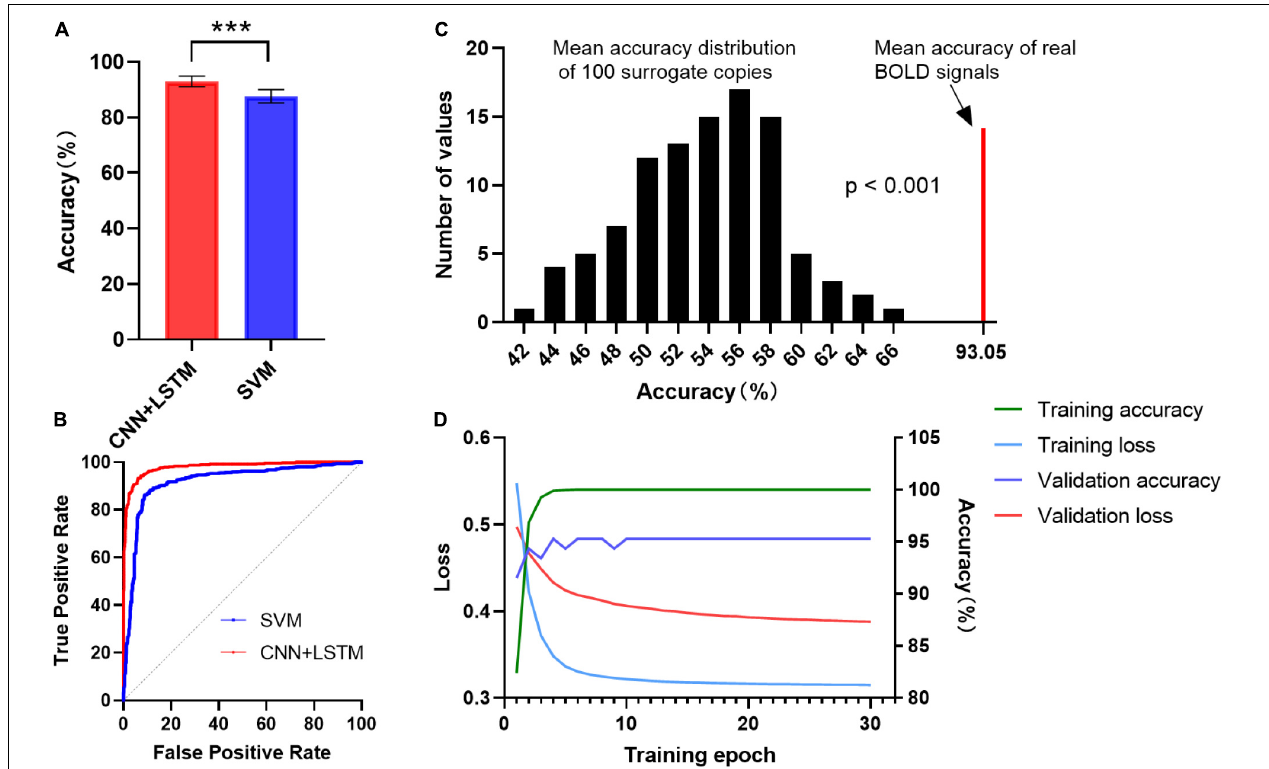
FIGURE 2 | ROC and accuracy for the gender classification task. (A) ROC curve across 10 testing folds for the CNN + LSTM and the SVM model. (B) Gender classification accuracy averaged across 10 testing folds. Bars refer to mean accuracy of all testing folds. Error bars indicate the standard error. Obviously, the CNN + LSTM model is statistically better than the SVM model (*** p < 0.001). (C) Accuracies of gender classification using the CNN + LSTM model on the real BOLD signals and their surrogate copies. A total of 100 surrogate data were generated by using MVPR to estimate the null distribution of classification accuracies (see section “Materials and Methods” for detail). With the mean classification accuracies as the statistic, results reveal that the classifier learned the connection dynamics with a probability of being wrong of < 0.001. (D) The learning curves while training the CNN + LSTM